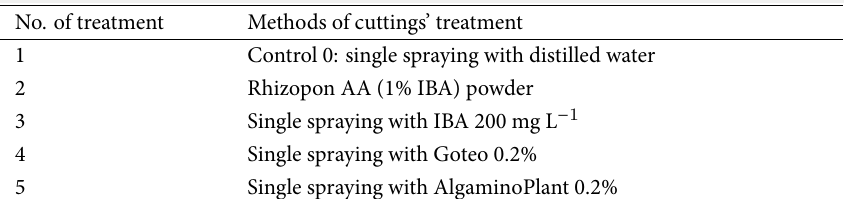
Table 1 List of treatments in the experiment.